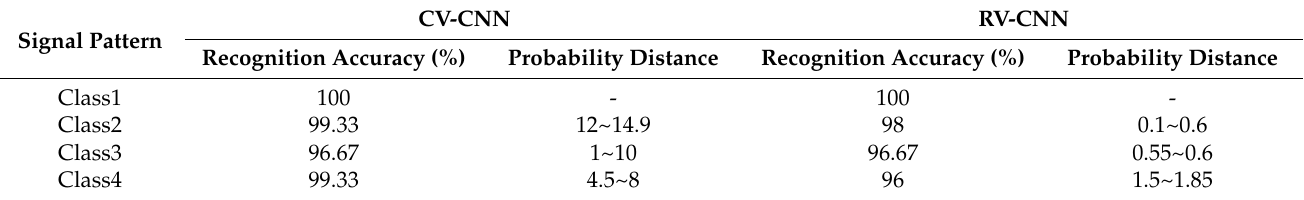
Table 4. Signal pattern recognition results of different network models when SNR = − 5 dB.